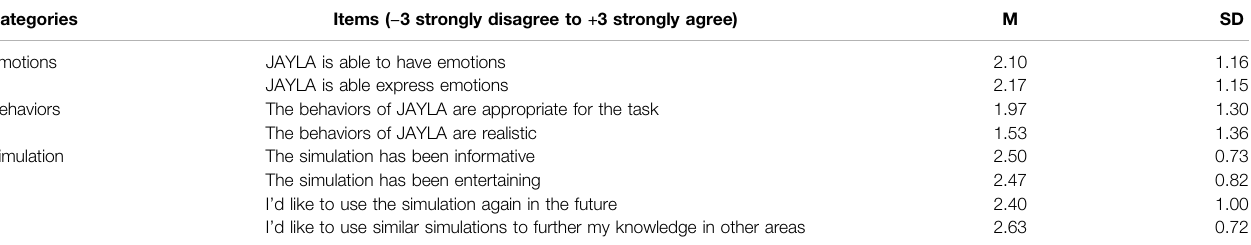
TABLE 2 | Summary of the trainees ’ ratings on emotions and behaviors of JAYLA and the simulation experience. Categories Emotions